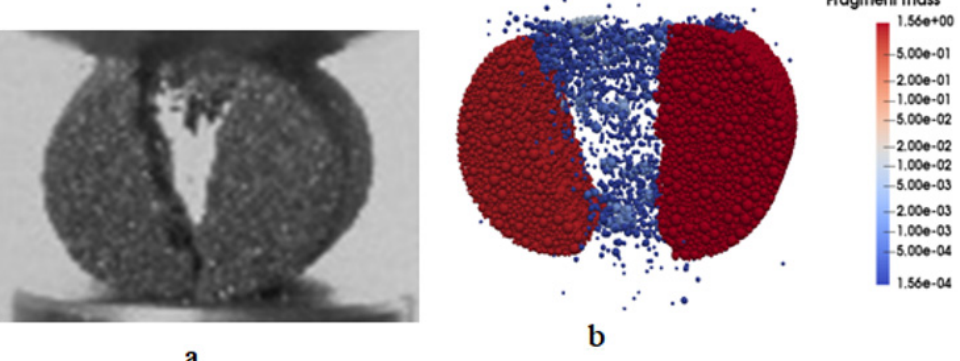
Figure 5. ( a ) Fragments generated from the SILC experiment [30]. ( b ) Fragments generated from the DEM simulation.